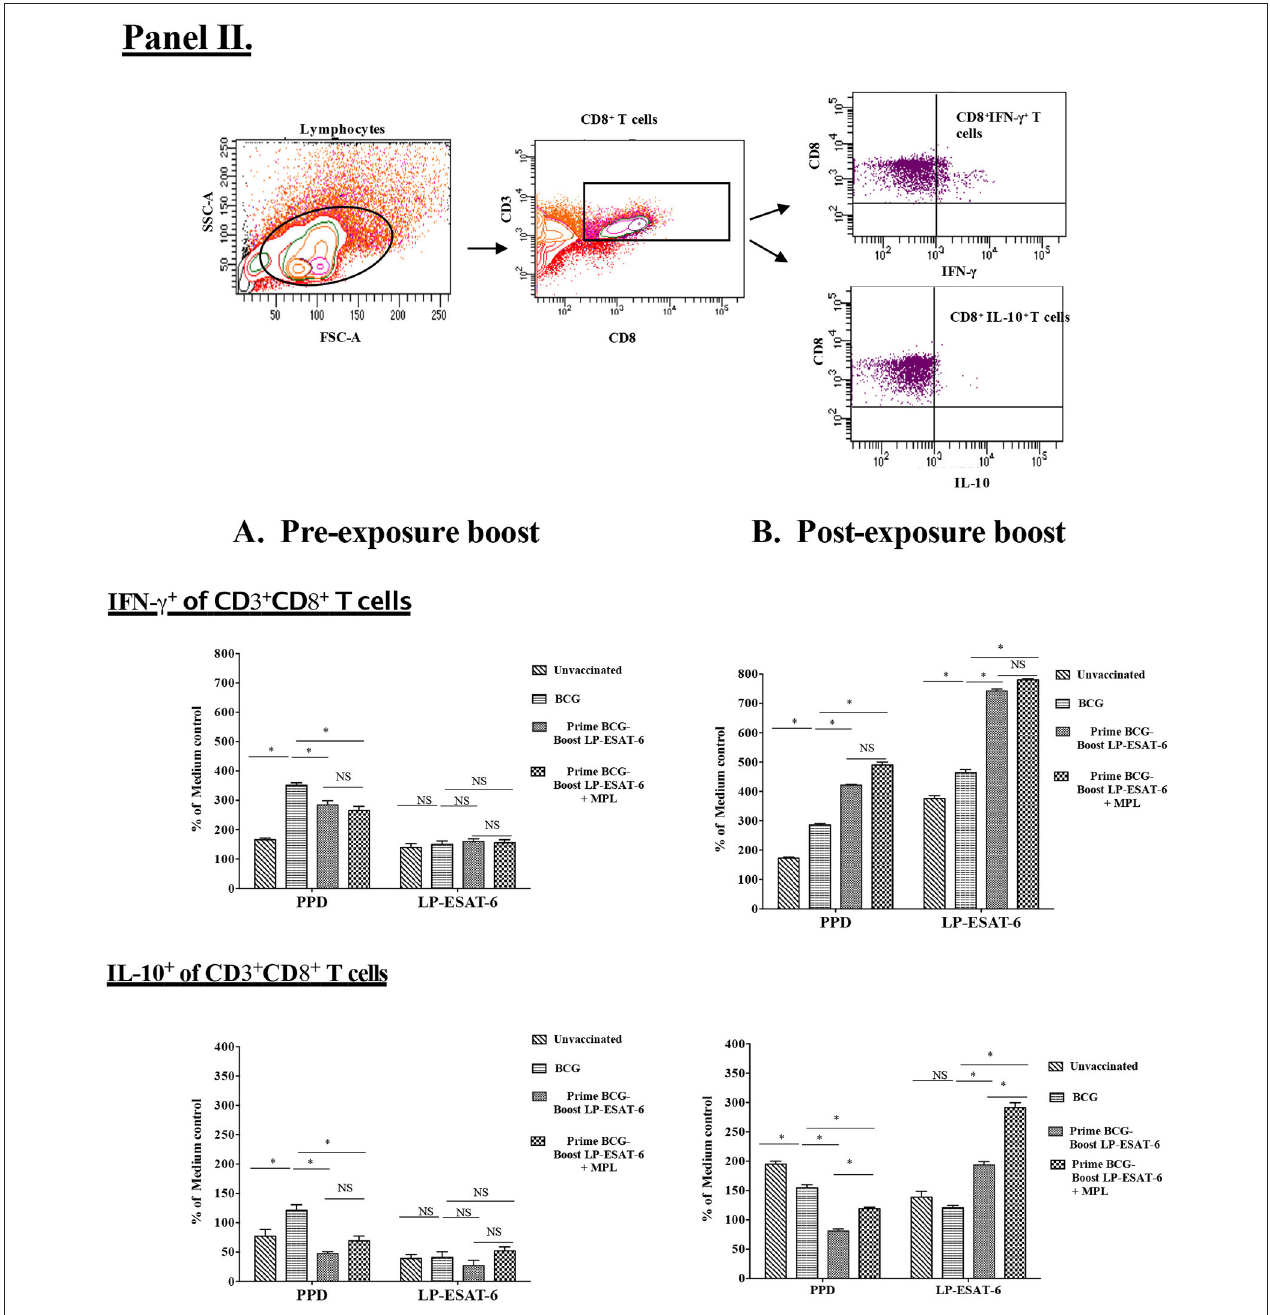
FIGURE 5 | Intracellular IFN- γ and IL-10 are differentially expressed in antigen-specific CD4 + (I) and CD8 + (II) T cells in BCG-primed mice boosted with LP-ESAT-6 subunit vaccine in pre-exposure or post-exposure schedule. Female BALB/c mice ( n = 5/group) were immunized according to the pre-exposure or post-exposure schedule shown in Figure 1 . Four weeks after infection, mice were euthanized and spleens were collected from (A) pre-exposure boost and (B) post-exposure boost groups. Spleen cells obtained from 5 mice immunized with lipopeptide P1 and P4-P7 were cultured for 4 days with or without PPD (1 µ g/ml) or lipopeptide mix (each of P1 and P4-P7 at 1 µ g/ml), cultured with Brefeldin A (1.5 µ g/ml) 1X; eBioscience) for 5h, and labeled with antibodies against CD3, CD4 and CD8 for extracellular staining along with intracellular IFN- γ and IL-10. The cells were gated for CD3 + CD4 + and CD3 + CD8 + , which were subsequently analyzed for IFN- γ or IL-10 expression as shown in the gating strategy shown above the bar graphs in each panel. Data are shown as the percentage of IFN- γ + or IL-10 + of CD4 + (I) and CD8 + T cells (II) upon stimulation with PPD or lipopeptide mix normalized to medium control in each of the experimental groups: unvaccinated, BCG alone, BCG prime/LP-ESAT-6 boost and BCG prime/LP-ESAT-6 + MPL boost in (A) pre-exposure and (B) post-exposure schedules. Mean ± standard deviation from triplicate cultures from spleen cells pooled from five individual mice are shown at the bottom. *denotes significant difference ( P < 0.05) between the compared groups and “NS” represents not significant ( P > 0.05). Data are representative of two repeated